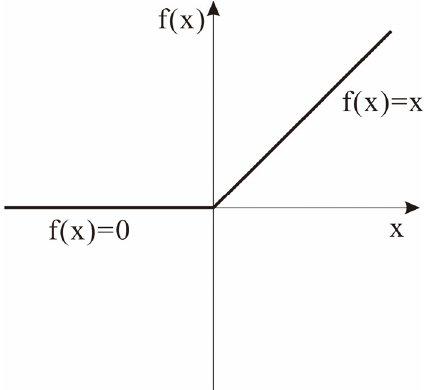
Figure 3. ReLU activation function.